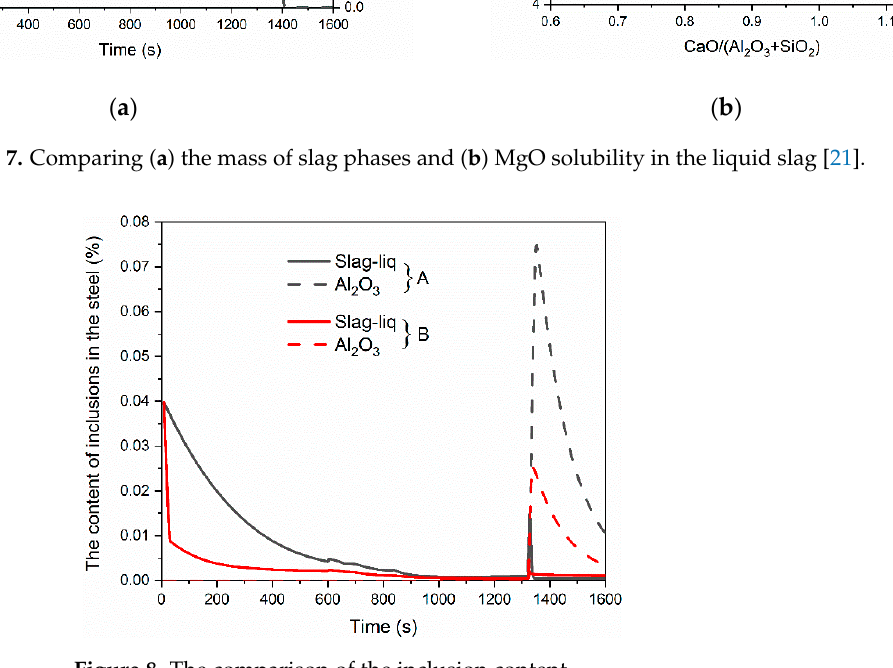
Figure 8. The comparison of the inclusion content.